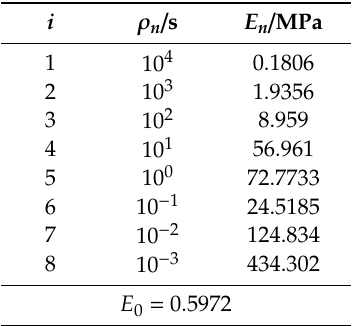
Table 1. Prony series coe ffi cients of relaxation modulus for asphalt